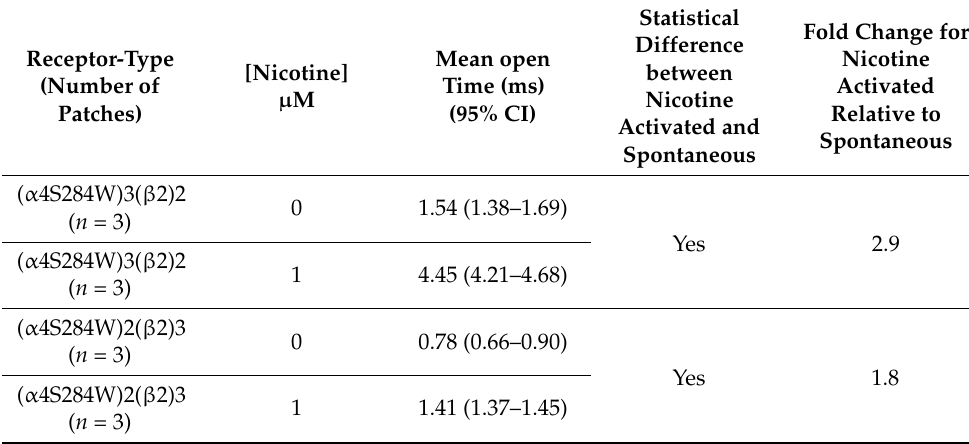
Table 3. Effect of α 4Ser284Trp on mean open times of spontaneous and Nicotine activated channel openings.